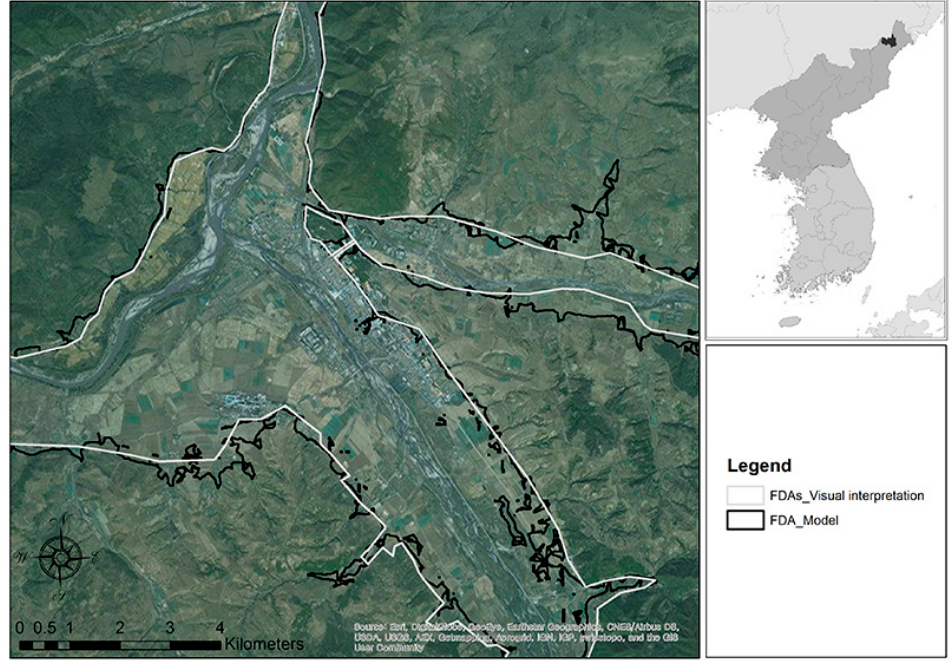
Figure 8. FDA map confirmation through a visual interpretation using Google Earth image. Table 5. Comparison of FDA maps for verification via Google Earth image.